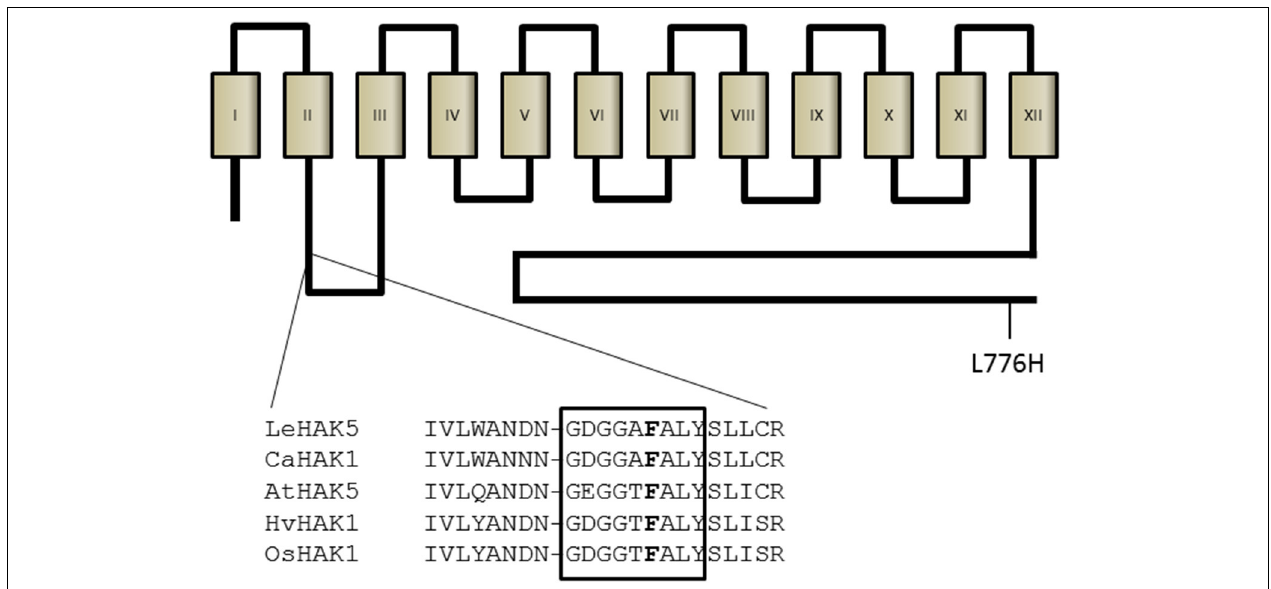
FIGURE 8 | Model of AtHAK5 topology and location of mutations. The proposed model for AtHAK5 protein is shown with 12 transmembrane domains and a long cytoplasmic C-terminus. The F130 residue is located between the second and the third transmembrane